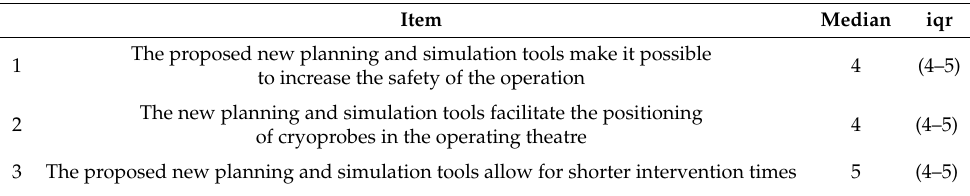
Table 6. Five point Likert questionnaire results for the Feedback on the Entire Platform (from 1 = strongly disagree, to 5 = strongly agree). The central tendency of responses is presented by the median, with the dispersion presented by the interquartile range